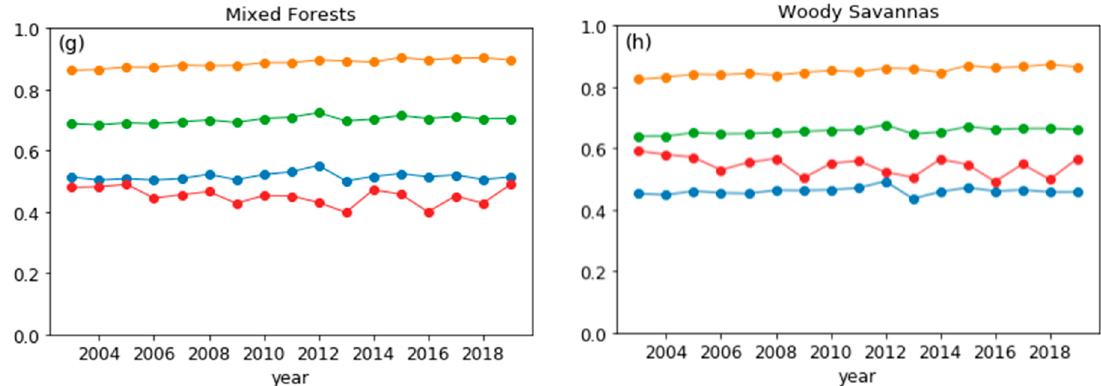
Figure 8. Time series analysis of drought indices in different land types. ( a ) Grasslands; ( b ) croplands; ( c ) barren; ( d ) deciduous broadleaf forests; ( e ) savannas; ( f ) urban and built-up lands; ( g ) mixed forests; ( h ) woody savannas.